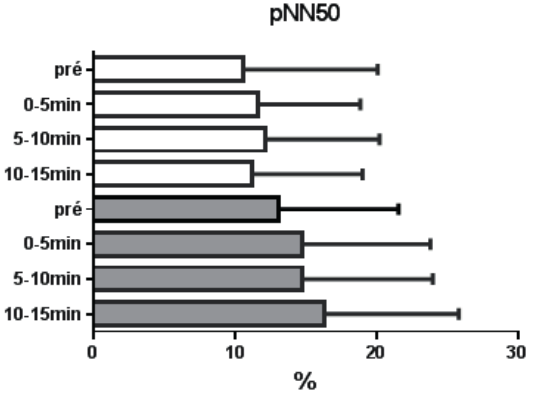
Figure 2 - Mean values of percentage of adjacent RR intervals, with duration difference greater than 50 milliseconds (pNN50), ob- tained from the tested group (white, n=11) and control group (gray, n=10). The HR values 0-5min, 5-10min and 10-15min refer to re- cords made after application of the massage, which are compared to the same times of the CG, which remained lying down, but did not receive massage. ns = no signi fi cative. There was no statistically signi fi cant differ- ence between the data.